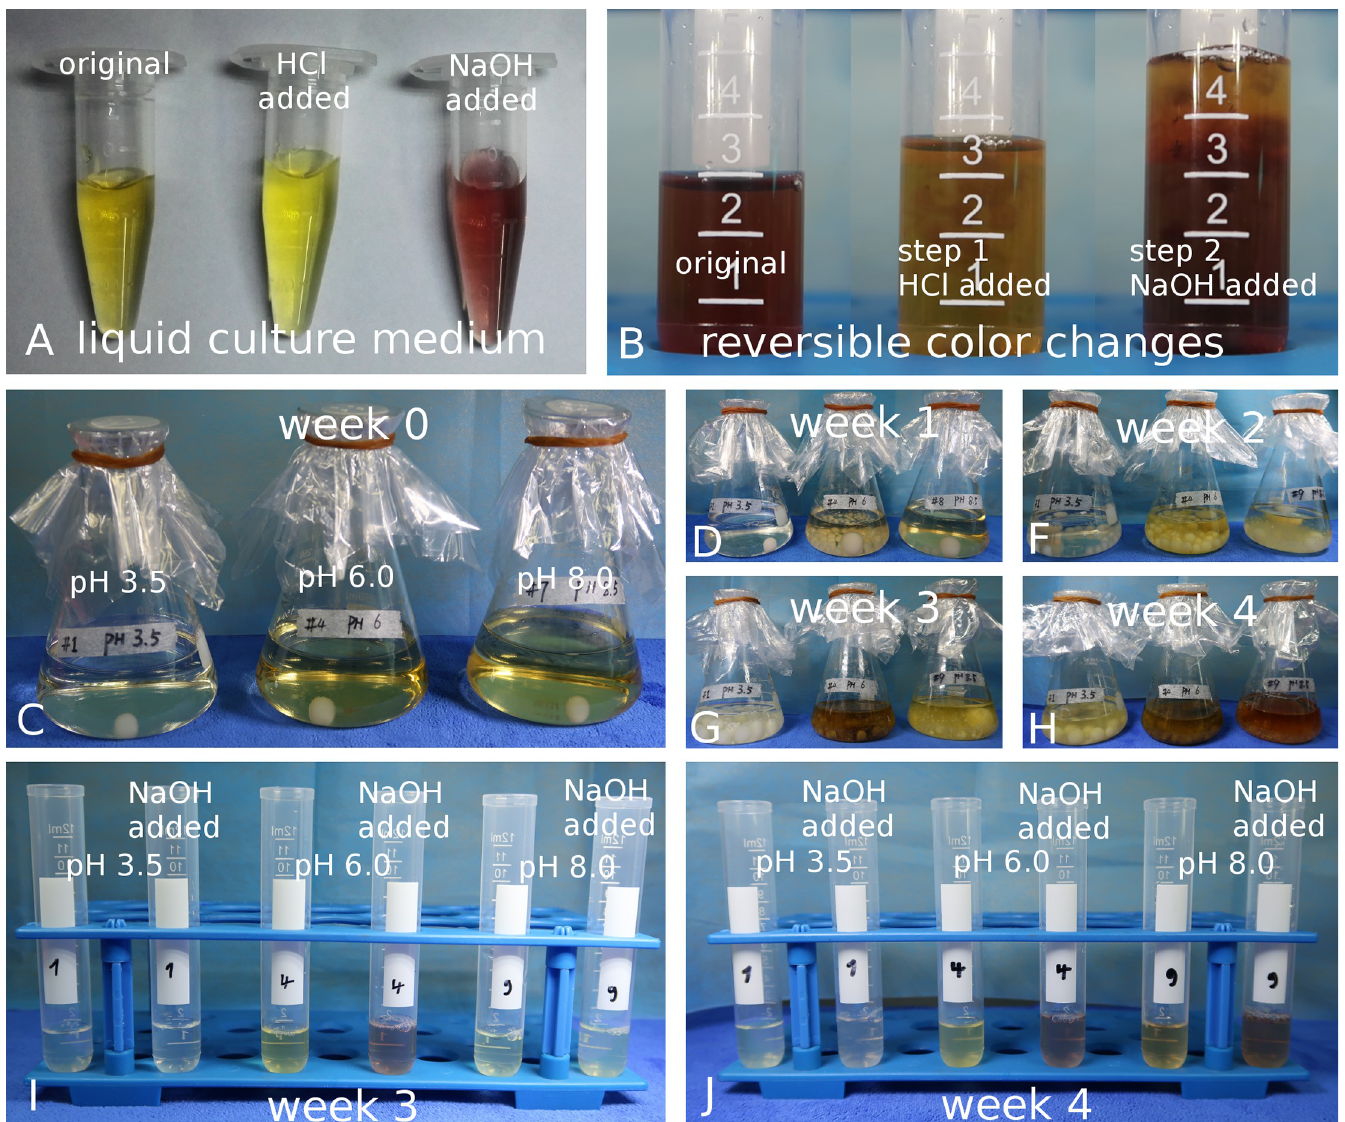
Fig 2. T . rubrum liquid cultures. A: Color change in 800 μ l liquid media of strain STRB008. The liquid culture is originally yellow (left tube). After adding 100 μ l 10% HCl the medium clears up (middle). By adding 100 μ l 1M NaOH the liquid medium turns wine-red (right). B: The color change can be reversed and re-reversed by adding alternately acid or alkaline. The original liquid medium of strains STRB012 is wine-red (left tube). After adding 0.5 ml of 10% HCl the color changes to yellow (middle). By adding 1.5 ml 1M KOH the color change can be reversed to wine-red (right). C-H: Liquid cultures of strain STRB012 over a period of 4 weeks. The pH was adjusted to 3.5 (left flask), 6 (middle) or 8 (right). C: One day after inoculation the culture liquid is transparent with a slight yellow coloration. D: One week after inoculation the pH 6 trial has the highest growth rate, followed by the one of pH 8. Only minor changes of the culture liquid are visible. F: After two weeks of inoculation a yellow coloration had develops in the pH 6 trial. G: After 3 weeks the liquid of the pH 3.5 trial is transparent, reddish in the pH 6 and yellowish at the pH 8 trial. After 4 weeks the culture liquid of the pH 6 and 8 trial is reddish. I, J: Comparison of the culture liquid of strain STRB012 with culture liquid after adding 200 μ l 0.2M NaOH. I: Comparison of culture liquid 3 weeks after inoculation. From left to right: pH 3.5 trial, pH 3.5 with NaOH, pH 6 trial, pH 6 trial with NaOH, pH 8 trial and pH 8 trial with NaOH. An obvious color change to red is seen only in the pH 6 trial. J: Comparison 4 weeks after inoculation. A weak color change is observed in the pH 3.5 trial and an obvious change is seen in the pH 6 and 8